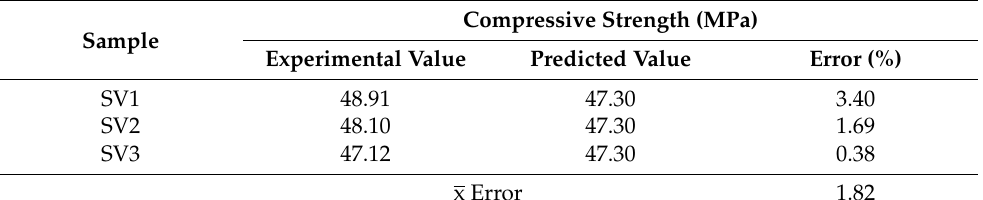
Table 8. Experimental validation for the compressive strength.